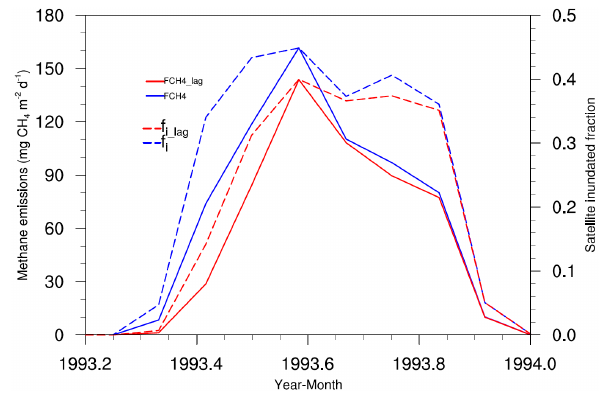
Fig. 9. Impact of redox potential on methane production and in- undated fraction at a grid cell (lat:48.31N, long:92.5W) extracted from global simulation. Dashed lines indicate satellite inundated fraction ( f i in blue) and delayed inundated fraction( f i lag in red); Solid lines are methane emissions with (FCH4 lag in red) and with- out (FCH 4 in blue) the inclusion of redox potential